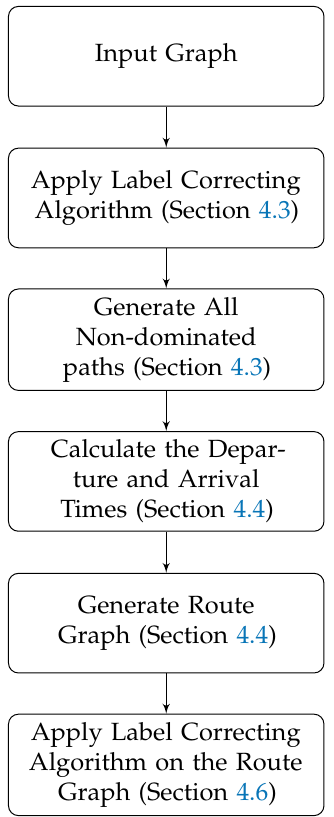
Figure 1. Process of generating all non-dominated